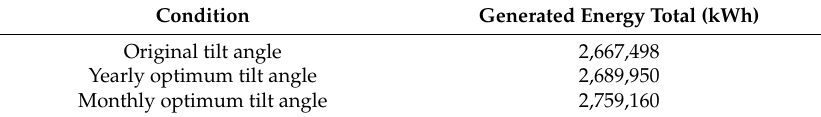
Table 8. 2017 yearly generated energy estimation for di ff erent tilt